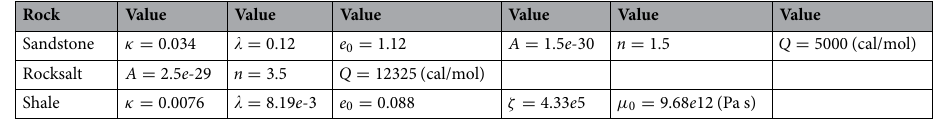
Table 5. Parameters of plasticity, viscoplasticity and creep used for different rocks 44,46,79,86 .